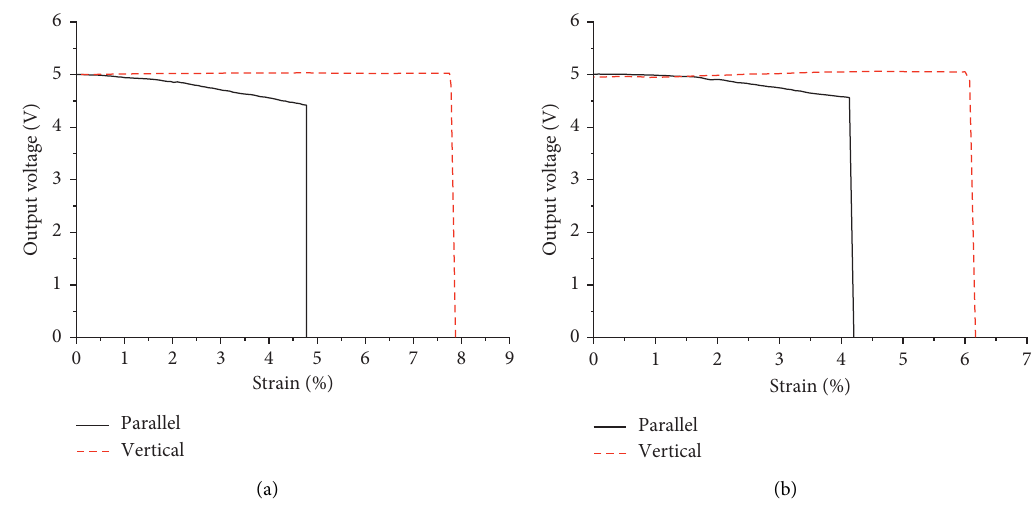
Figure 13: Output voltage-strain curves of the square specimen. (a) Warp. (b)